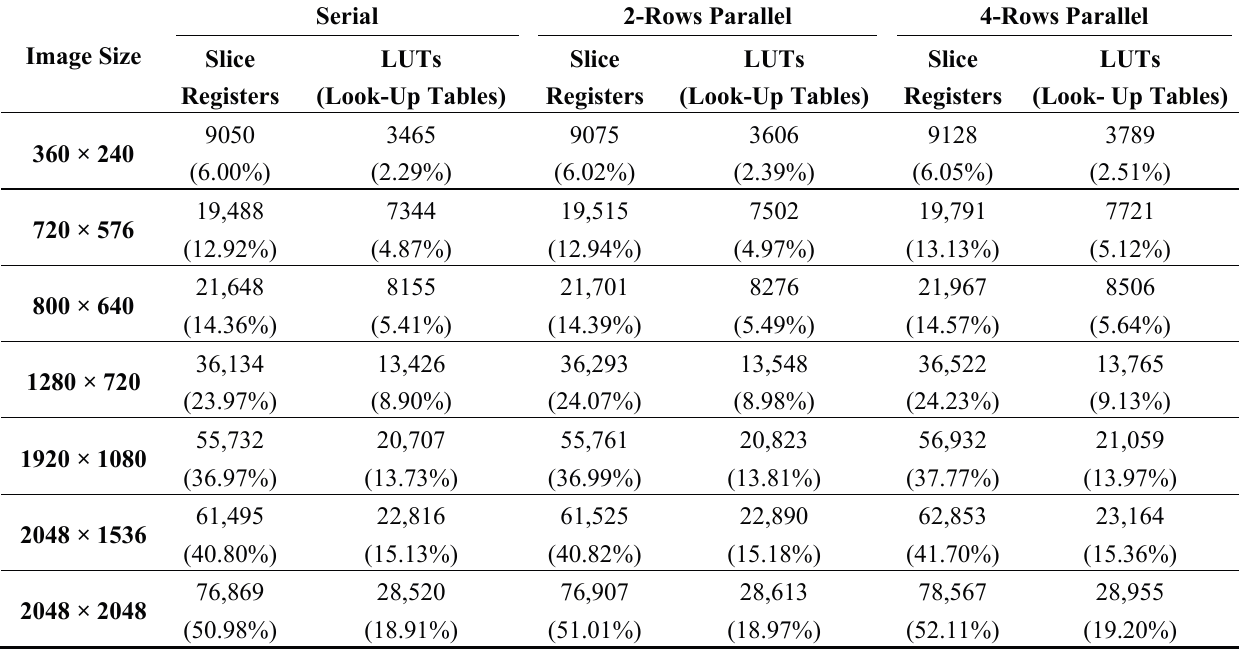
Table 1. Comparative resource utilization results for Serial, 2-rows and 4-rows